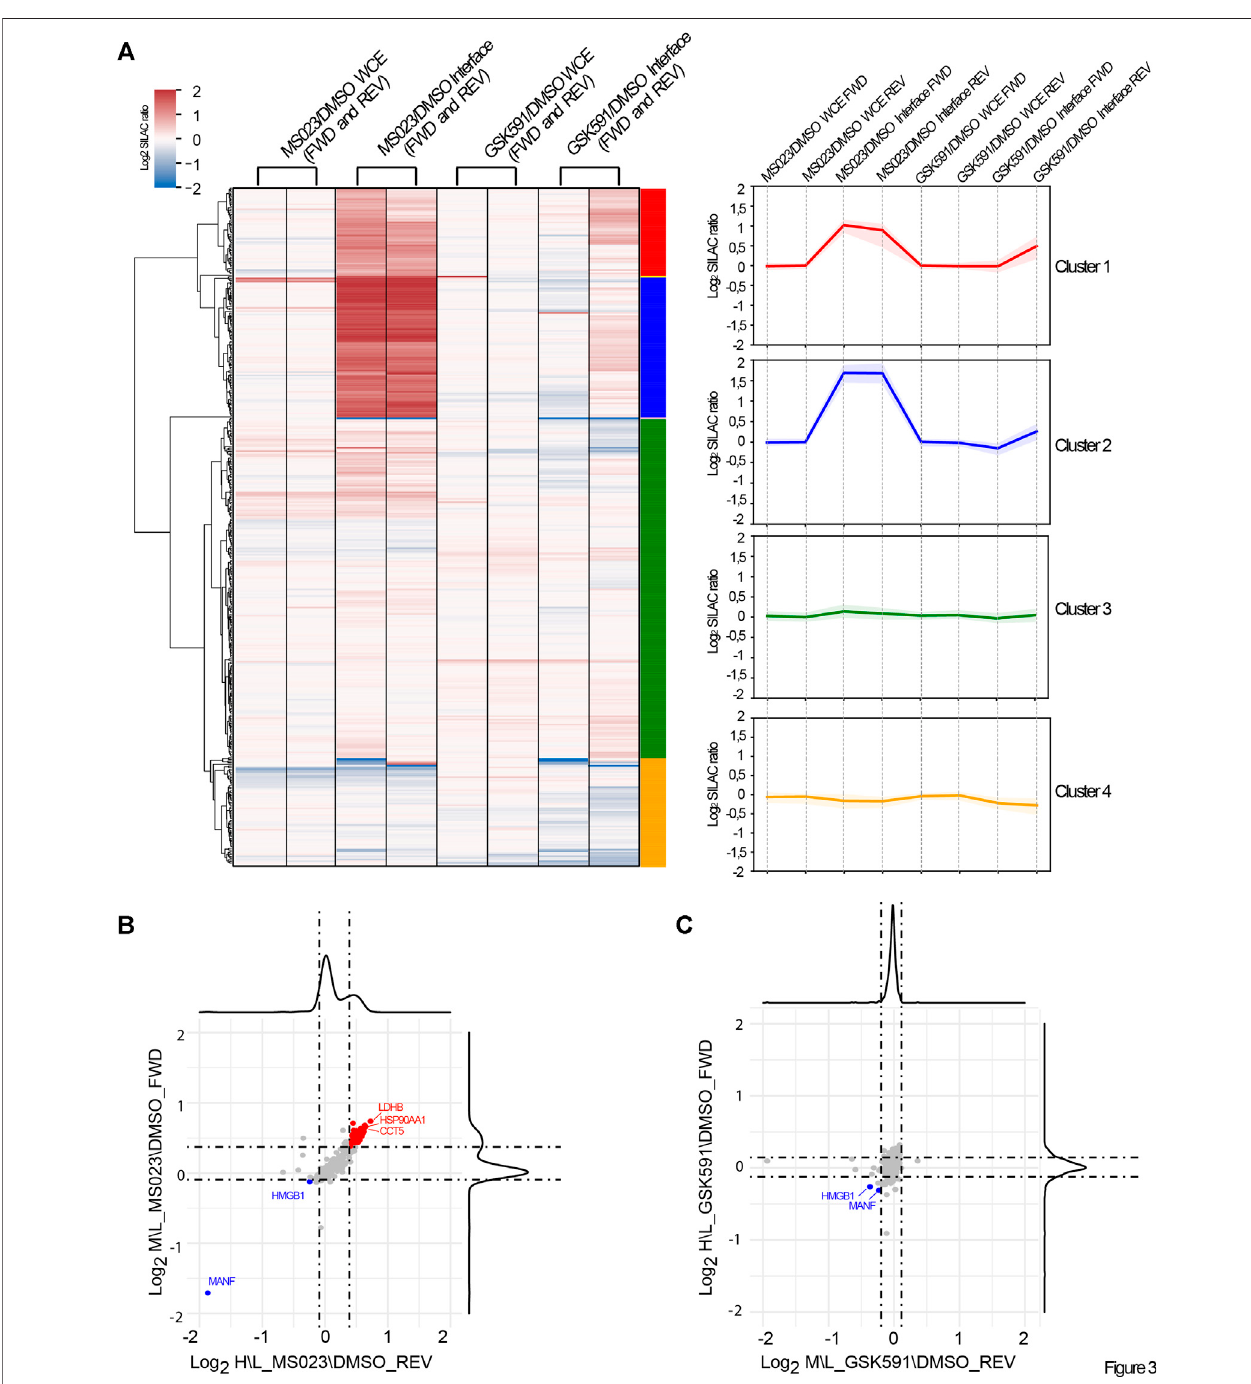
FIGURE3| DynamicsofRBP-RNAinteractionsindependence ofPRMTpharmacological modulation. (A) SupervisedclusteringanalysisofthequantitativeOOPS proteomics data. Supervised clustering analysis of differential protein expression or differential RNA-binding after MS023 and GSK591 treatment normalized on DMSO ledtotheidenti fi cationoffourrepresentativeclusters:Cluster1andCluster2containproteinswithLog 2 SILACratioMS023/DMSO+1and+1.5,respectively,onlyinthe interface fraction; Cluster 3 and Cluster 4 contains proteins overall not signi fi cantly modulated in the interface, with Cluster 4 displaying a mild decrease in the interfaceuponGSK591( − 0.3Log 2 SILACratios). (B) ScatterplotrepresentationofthenormalizedLog 2 SILACratioinMS023-treated condition.ScatterplotoftheLog 2 MS023/DMSOSILACratioofinterfaceproteins,normalizedontherespectiveproteinSILACratiointheWCE,inFWDversusREVexperiment.Dashedlinesindicate μ ± σ of the respective SILAC protein ratio distributions; proteins up- or down-regulated are displayed in red and blue, respectively. (C) Scatter-plot representation of the normalized Log 2 SILAC ratio in GSK591 treated condition. The scatter plot displays the Log 2 GSK591/DMSO SILAC ratio of interface proteins, normalized on the respectiveSILACratiointheWCEinFWDversusREVexperiment.Dashedlinesindicate μ ± σ oftherespectiveSILACproteinratiodistributions;proteinsdown-regulated are displayed in